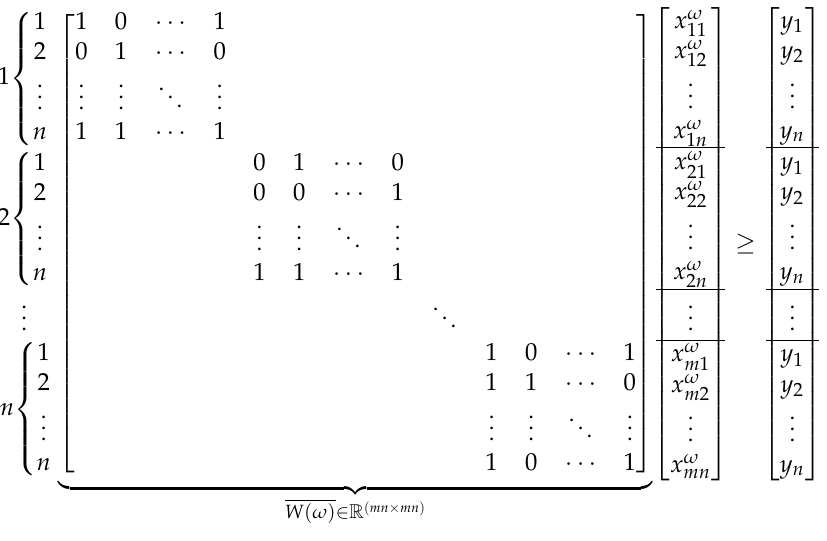
Figure 1. An example of the matrix W ( ω ) .